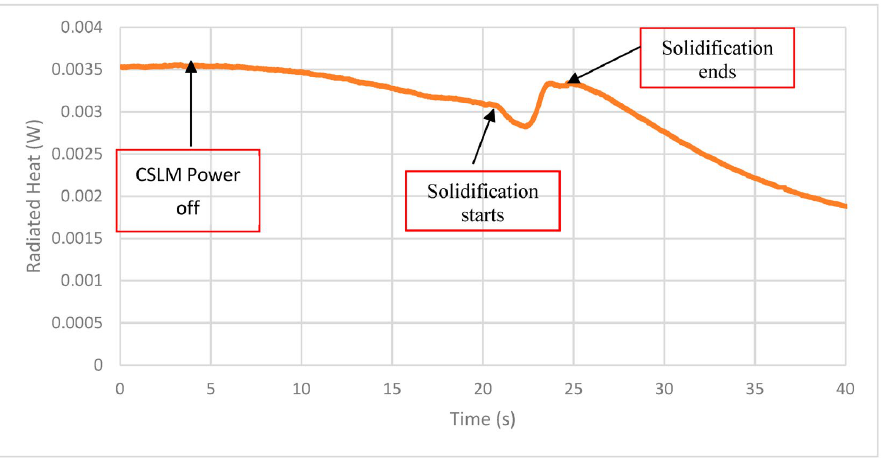
Figure 13. Radiated heat curve for the surface of the steel sample that was solidified in argon. Reproduced from [72] under license CC BY 4.0.